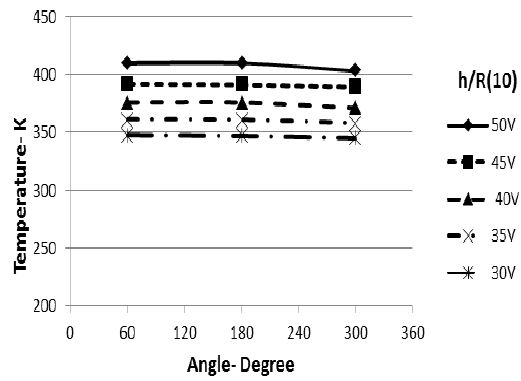
Figure 7. Average face temperature with different voltages at a depth/radius ratio of 10.